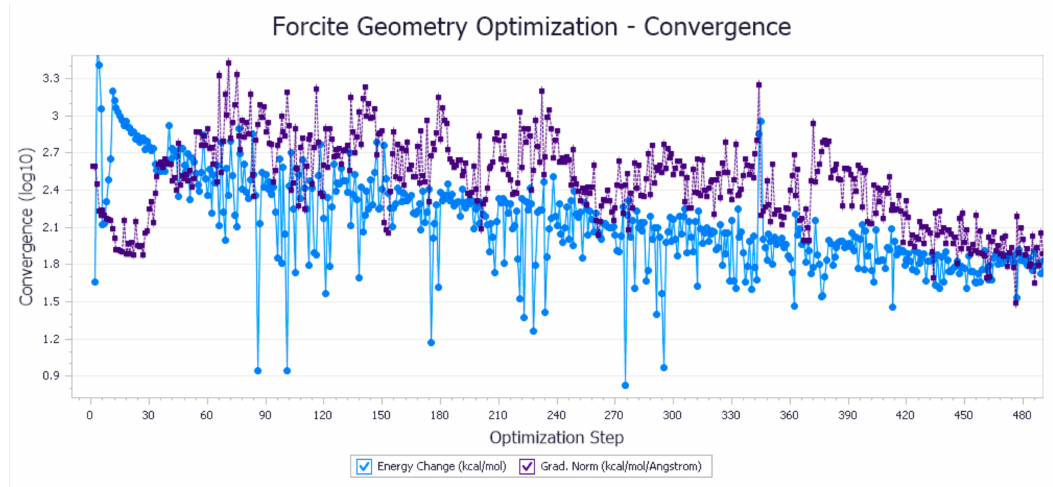
Figure 15. Demulsifier12# oil–water interface geometric optimization